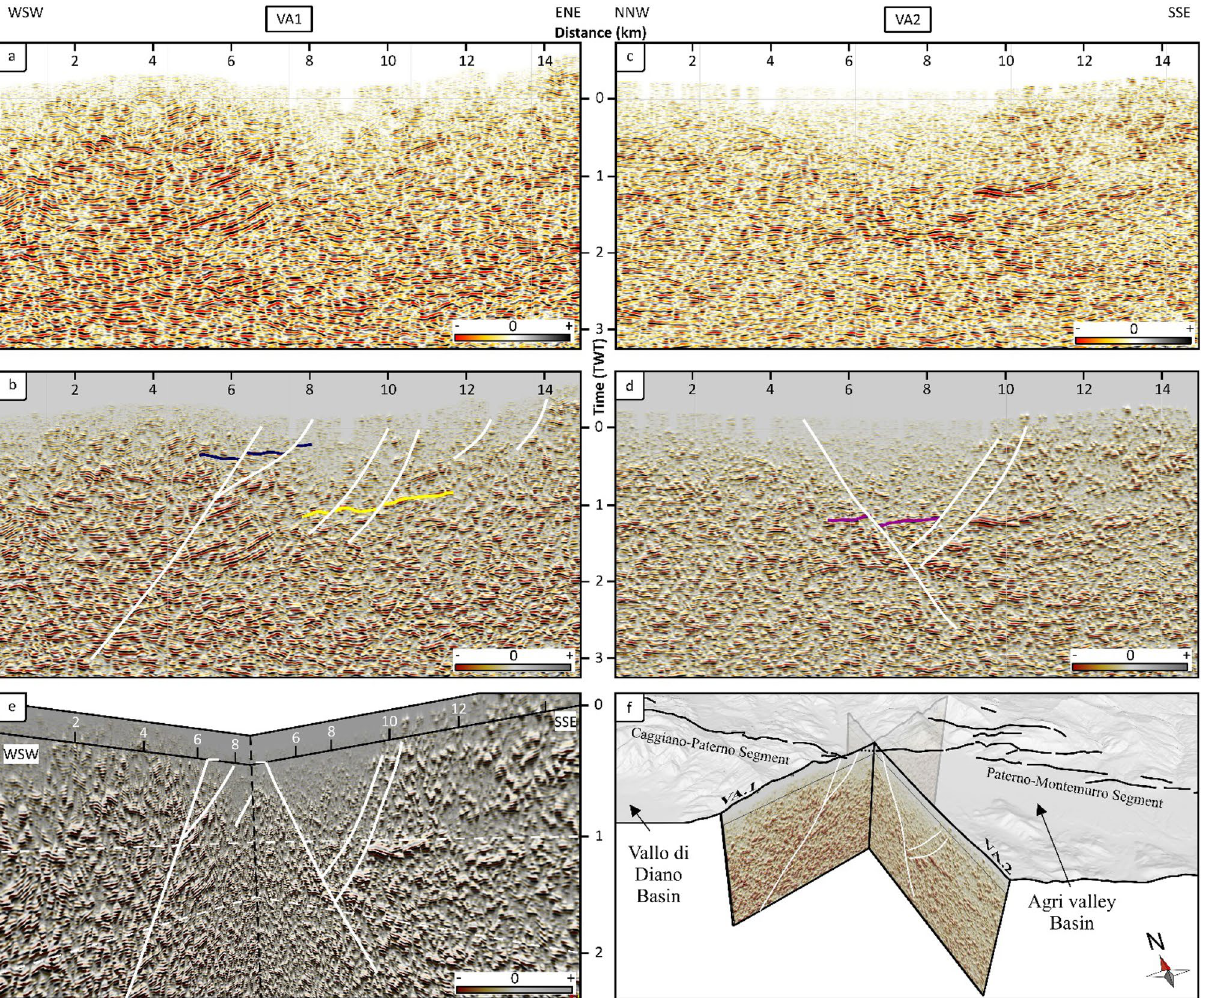
Figure 4. Seismic reflection profiles showing the subsurface seismic signature of the CMF; ( a , c) conventional seismic reflection profiles in amplitude, after the application of pre-conditioning filters (PCf), showing a consistent reduction of high-frequency random noise; ( b , d) co-rendering of PR attribute overlapped in transparency by PCf of panels ( a – c ), with line-drawing of the interpreted faults (white) and displaced reflections (yellow); ( e) 3D view of the intersection between the two seismic lines (PR + PCf), focused in a key-sector of the study area; ( f) a bird’s eye view of the two profiles beneath an hillshaded 10 m-resolution topography in transparency (gray layer) including the CMF trace (black) mapped at